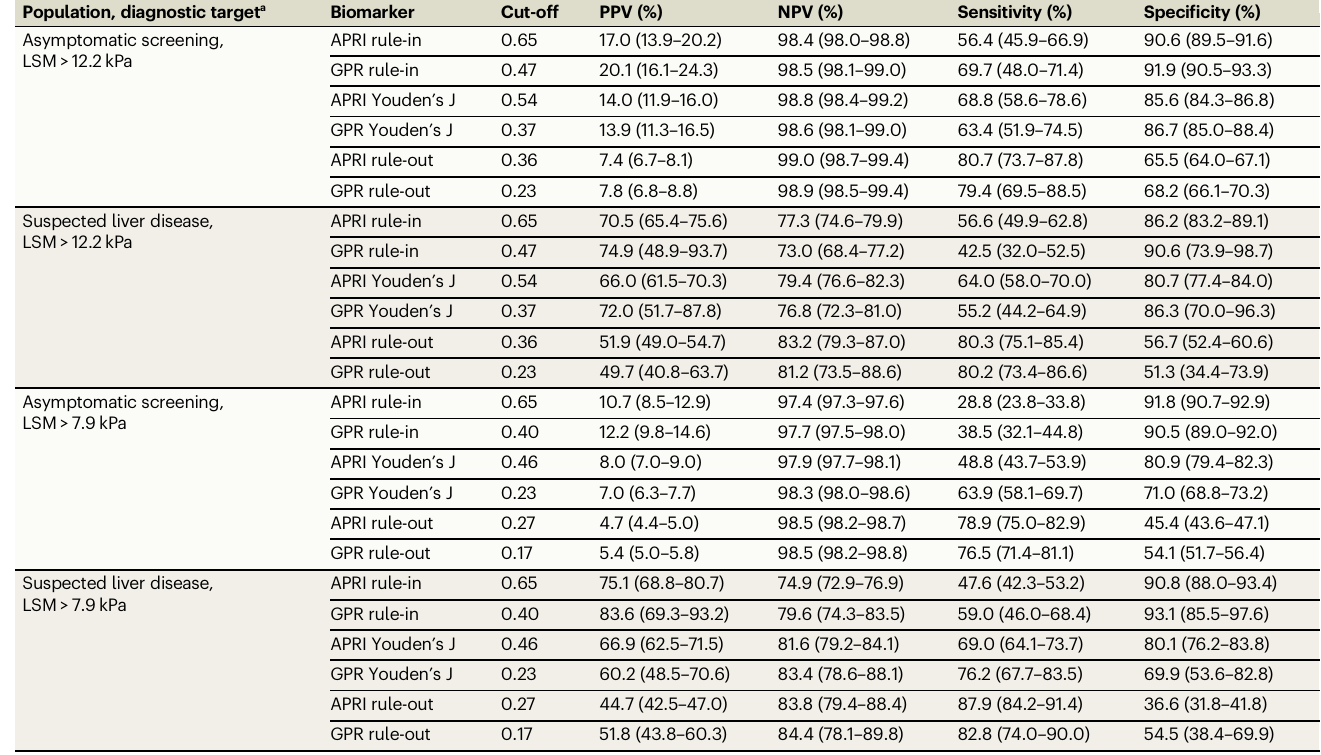
Table 2 | Predictive values, sensitivities and speci fi cities for different study populations for APRI and GPR Population, diagnostic target